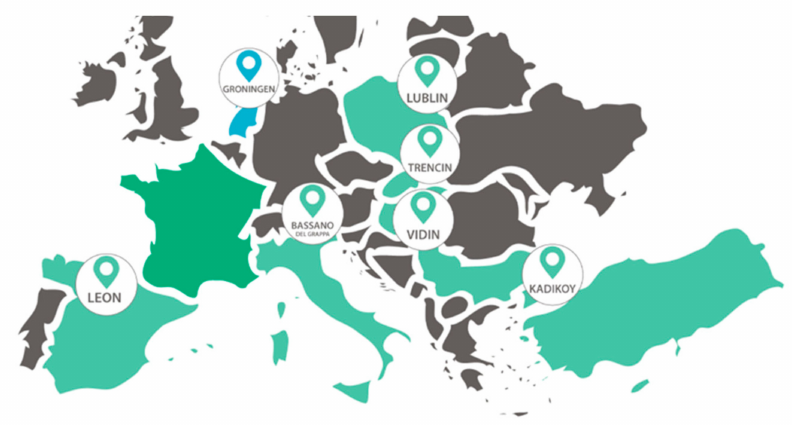
Figure 2. MAKING-CITY Project—follower